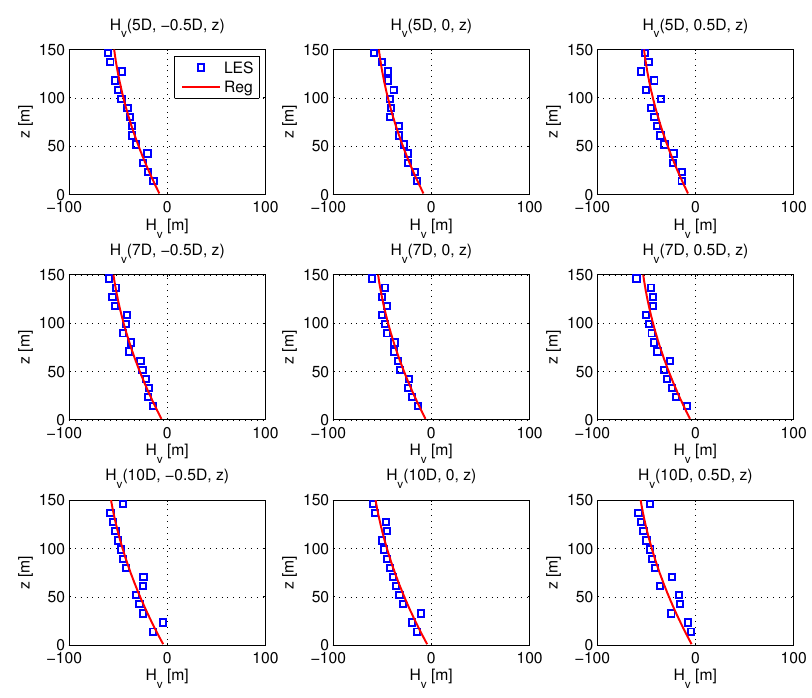
Figure 25. Spatial variation of H v : LES versus regression-based estimation.